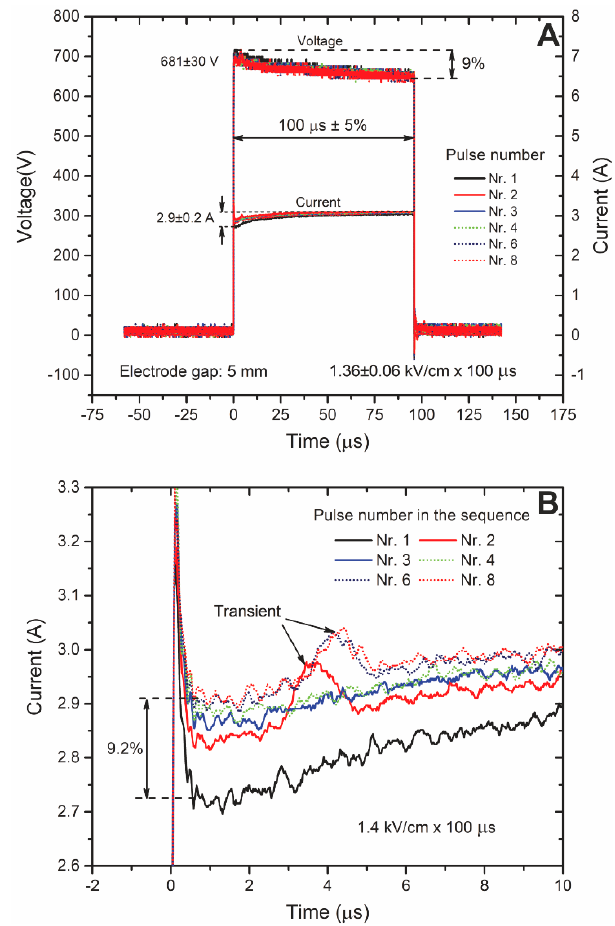
Figure 6. The current and voltage waveforms ( A ) during the microsecond range electroporation and the magnification ( B ) of the current pulses for better informativity.